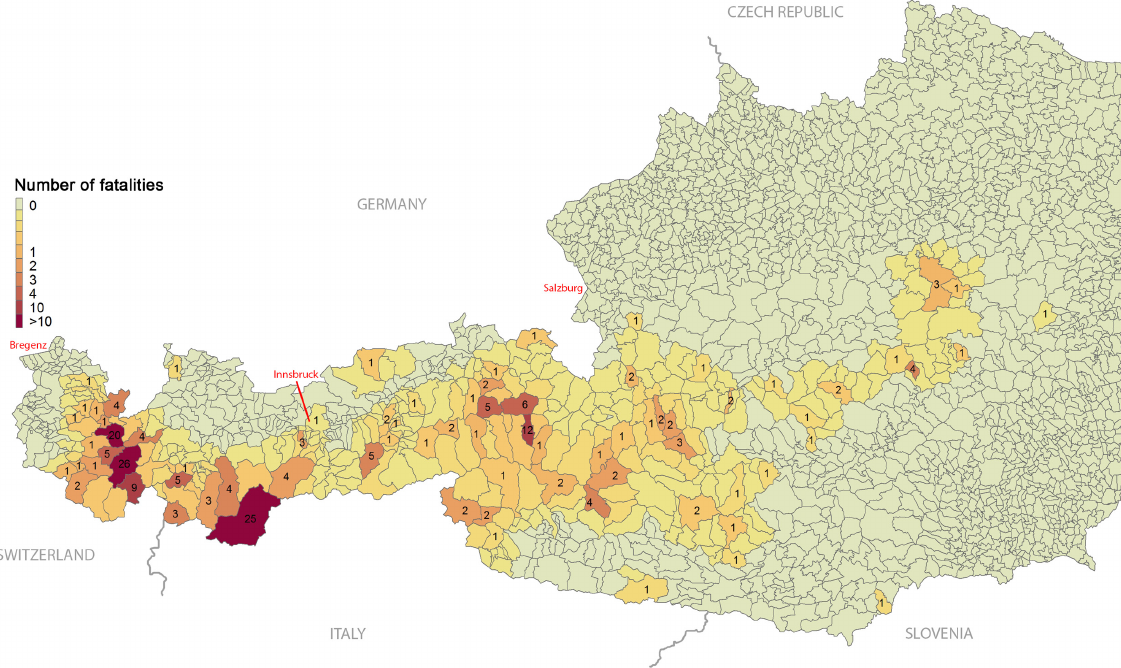
Figure 10. Regional distribution of avalanche fatalities (off-piste) in Austria within